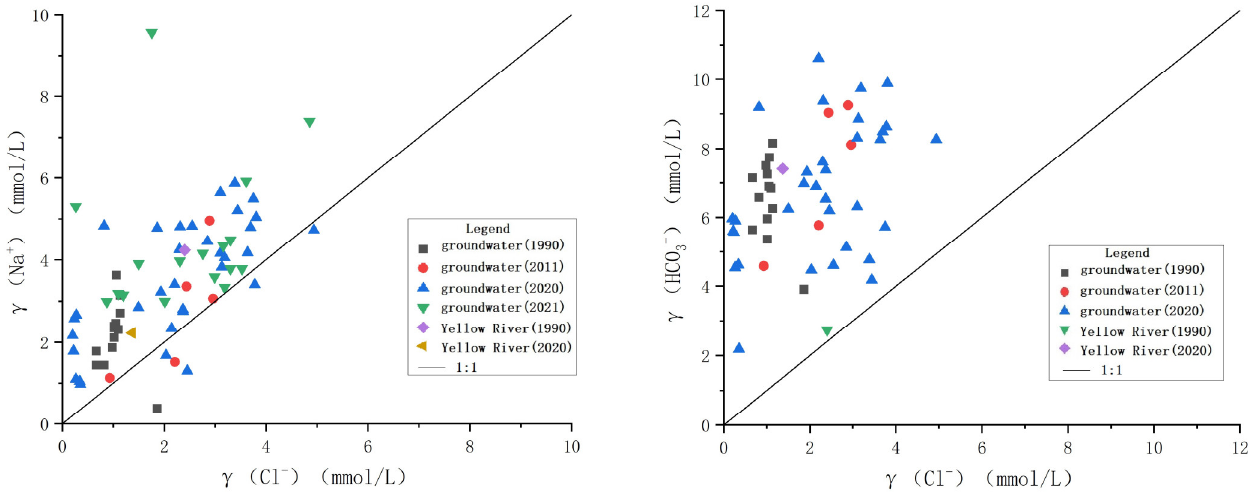
Figure 13. γ(Na + )/γ(Cl − ) and γ(HCO 3− )/γ(Cl − ).